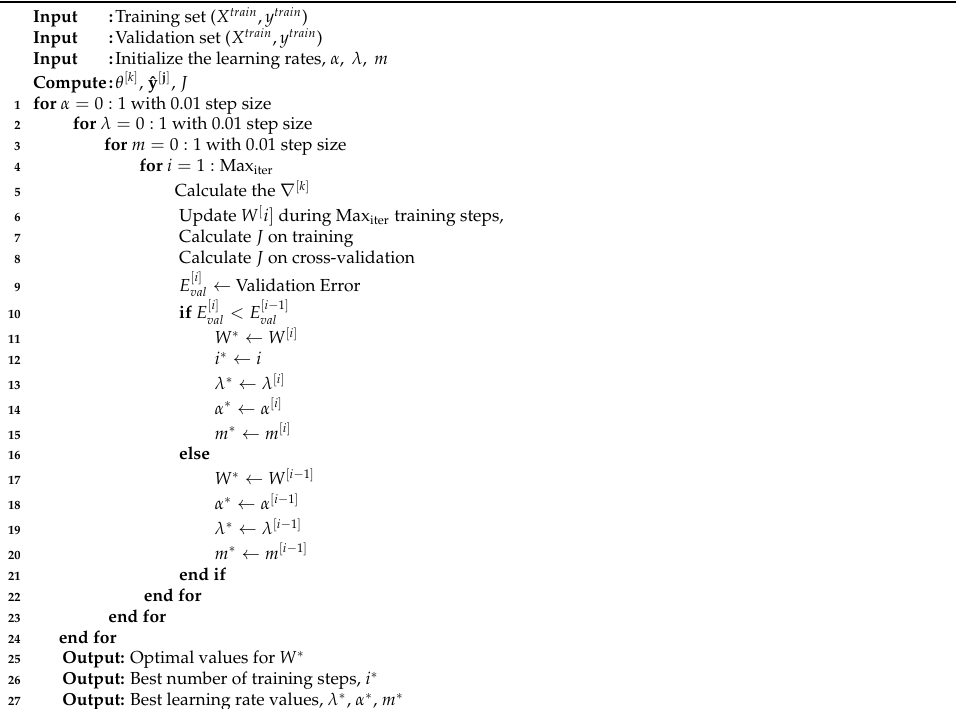
Figure 1. The proposed learning-based detection algorithm is illustrated. The top left box demon- strates a water distribution benchmark, used to generate hourly data points. On the bottom left, in an “offline mode”, the historical data are split into “training" , “cross-validation" (CV), and “testing" data sets. The training and CV data sets are introduced to the proposed deep learning algorithm to train the hyper-parameters and update the weights, while testing data set is used to evaluate the performance of the trained network. Once the algorithm is effectively trained, it will be integrated in the SCADA system to identify the FDI cyberattacks in the WDS in real time. Algorithm 1: Proposed deep learning detection